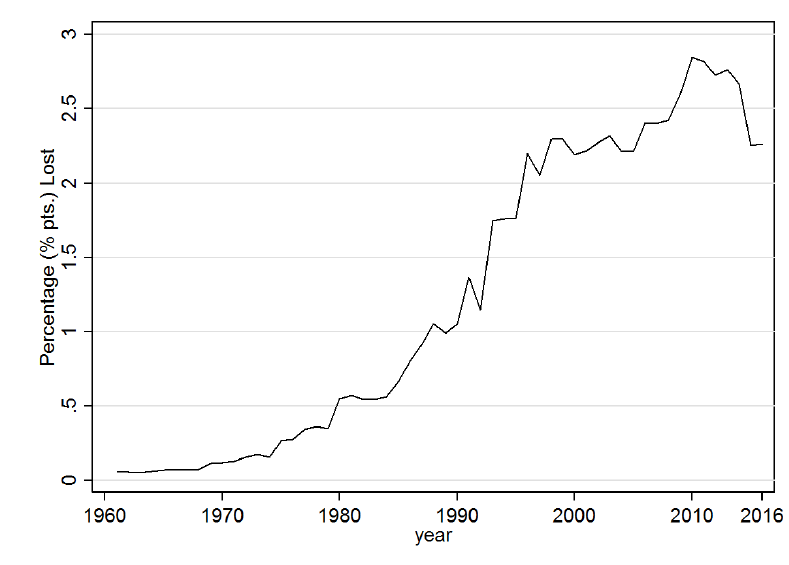
Figure 8. Potential Losses (%). Note: This figure provides the percentage of predicted losses as estimated from the linear regression model in Equation